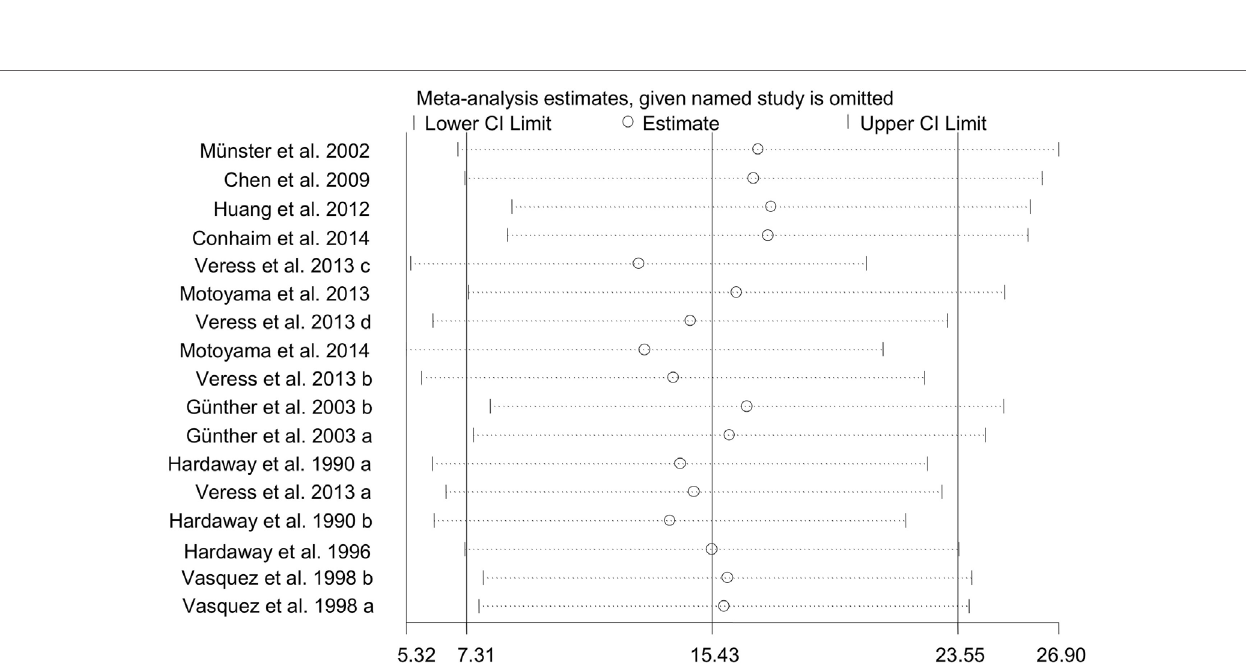
FiGURe 7 | Bias assessment of PaO 2 from 18 studies. (a) Funnel plots of precision (1/SE) as a function of weighted mean differences (WMD) showing the distribution of published study outcomes (filled circles). Vertical gray line is a global estimate of efficacy. (B) Egger regression of PaO 2 precision (1/SE) against WMD/SE.